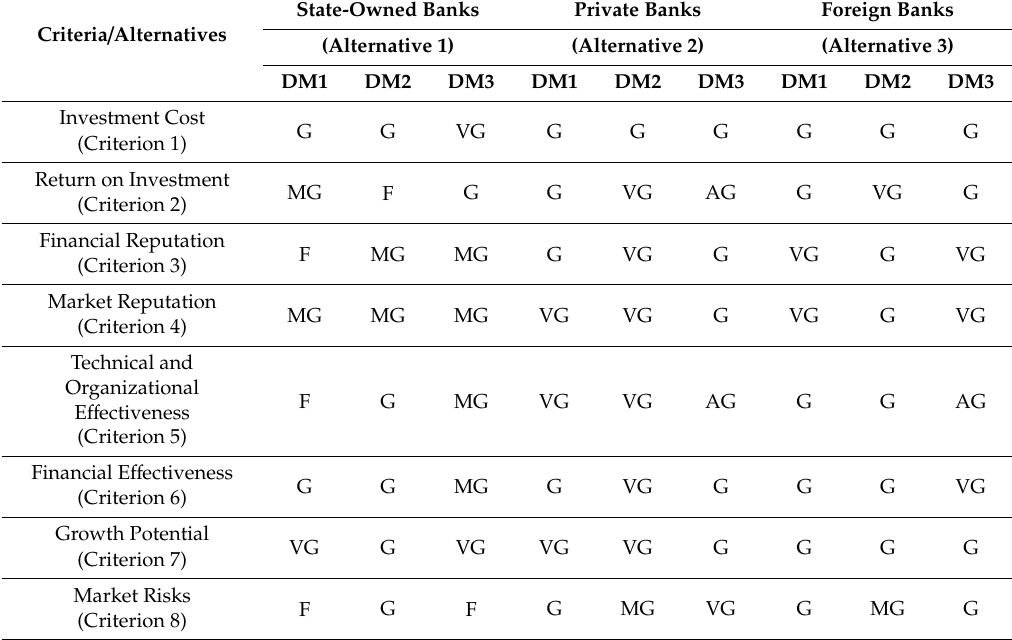
Table 4. Linguistic Evaluations of Decision Makers for